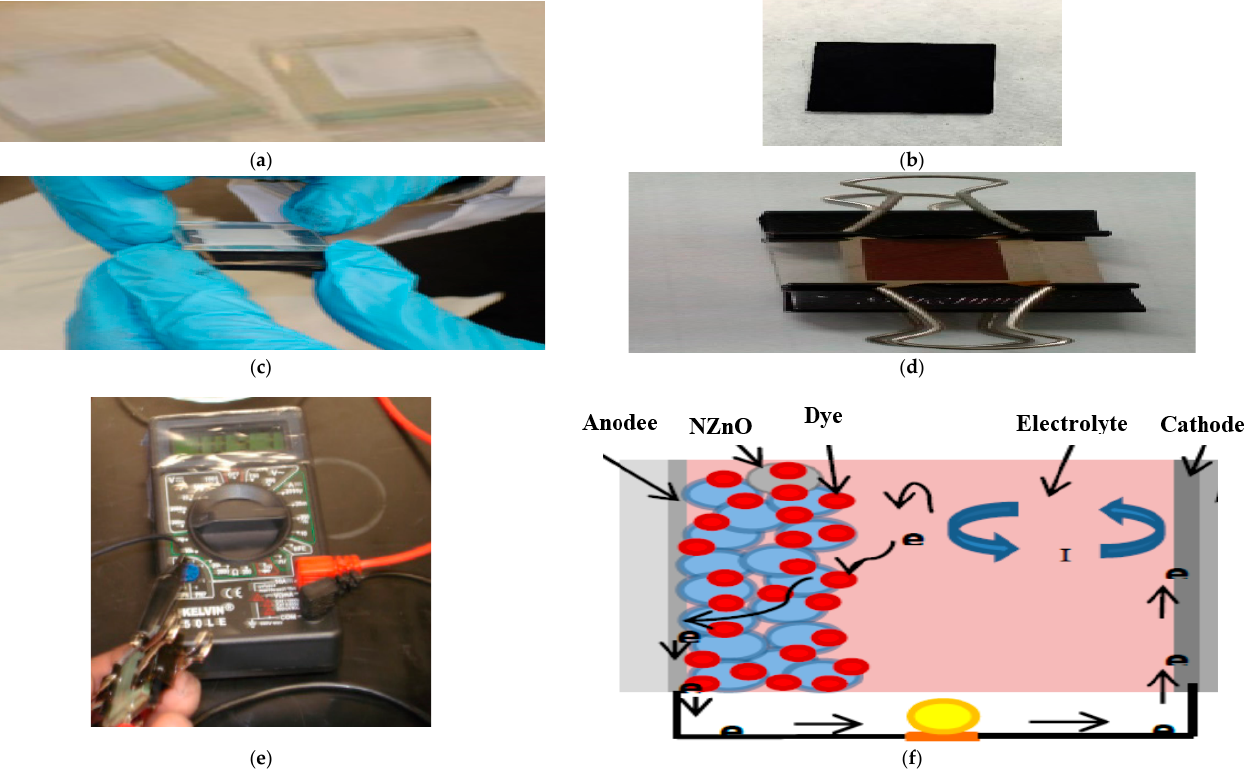
Figure 3. Assembling a Complete Dye-sensitised Solar Cell. ( a ) ZnO paste on FTO coated slide ( b ) FTO slide with carbon soot ( c ) ZnO coated slide placed over carbon slide and over cathode slide ( d ) Binder clips sandwiched anode coated slide ( e ) Testing the solar cell’s voltage using a multi-meter ( f ) Schematic drawing of a DSSC together with simplified electron transfer